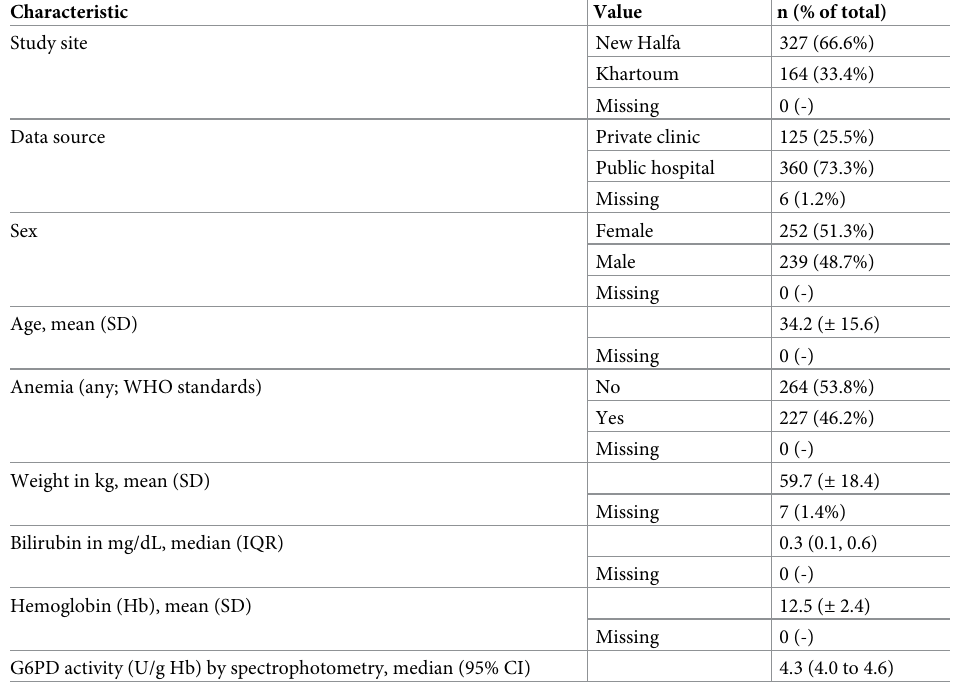
Table 1. Study population overview G6PD surveys, New Halfa and Khartoum Sudan, 2015 (N = 491).